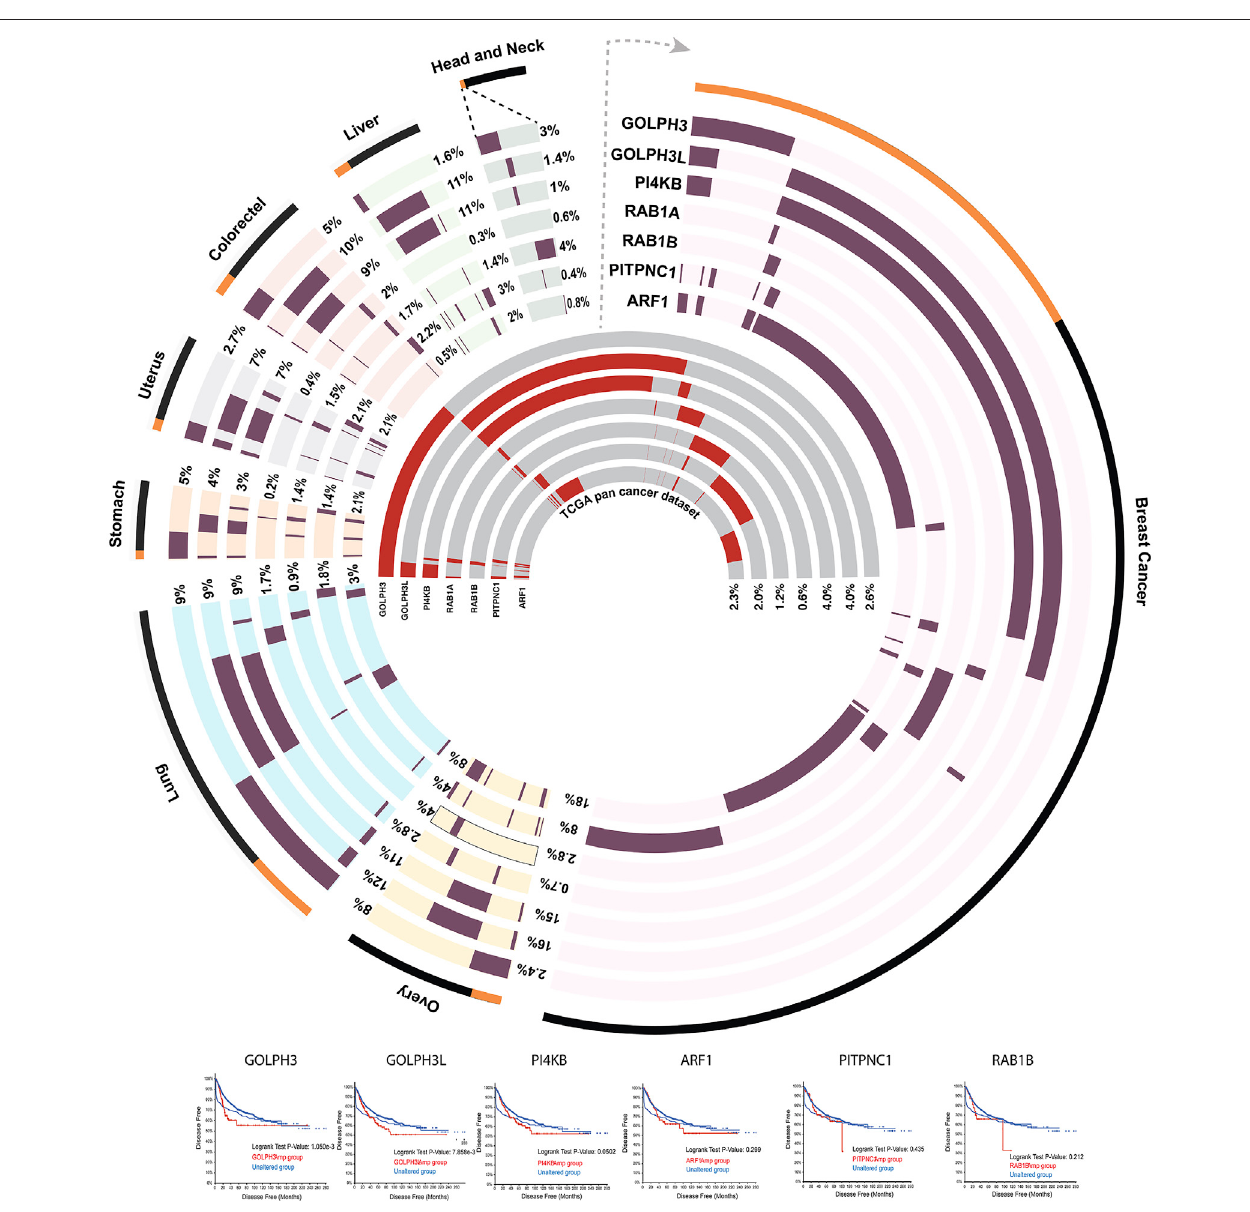
FIGURE 5 | Circos plot (Krzywinski et al., 2009) showing the ampli fi cation frequency of seven CMM genes in the top eight cancer types in which they are more frequently ampli fi ed. The outermost layer showing the percentage of samples (orange) that have ampli fi cation in at least one of the seven CMM genes considered, comparedtototalnumber(black)ofsamplesinthestudy.Nextseventracksshowingtheampli fi cationfrequency(darkmaroon)ofeachgeneintheindividualcancertype considered. The seven inner most tracks represent ampli fi cation frequency (red) of each of the CMM gene considered across whole repertoire of 32 different pan cancers reported in The Cancer Genome Atlas (Gao et al.,